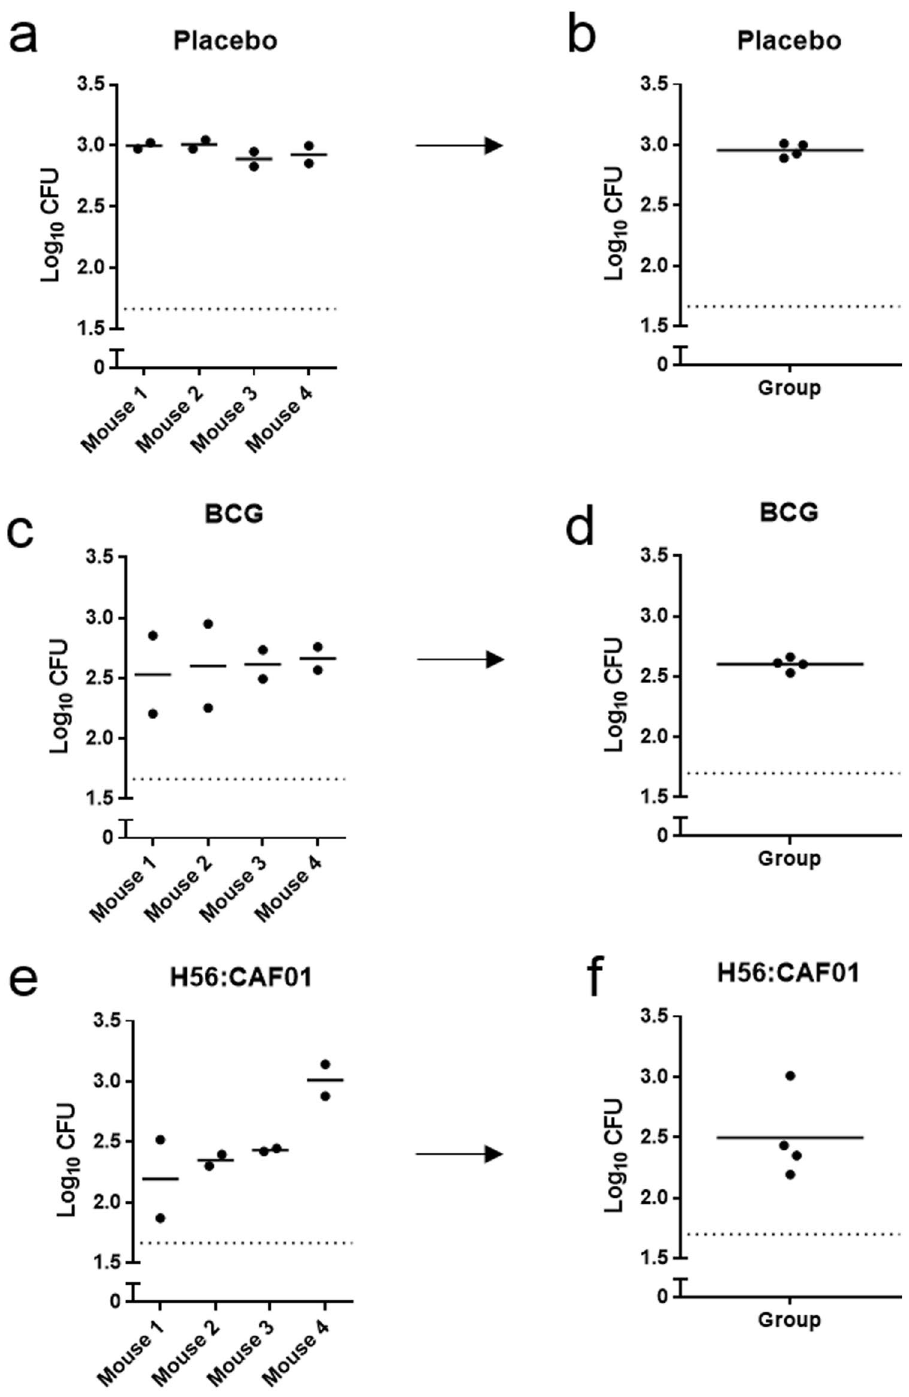
Figure 2. Assay variability. Groups of mice were immunised three times s.c. with H56 in CAF01 ( e , f ), one time with BCG ( c , d ) or placebo (Tris buffer) ( a , b ) with 2-week intervals. Splenocytes from individual mice (n = 4) were isolated one week after the last immunisation and co-cultured with 50 CFU of M.tb Erdman in the four days MGIA. The mean